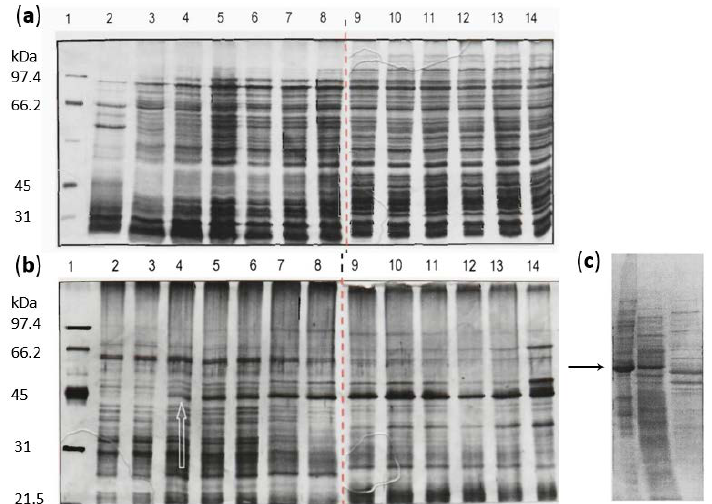
Figure 2. SDS-PAGE gel images for GCRL 46 cells cultured at pH 6.3 or 4.0. Cells were cultured anaerobically in fermenters at set pH of pH 6.3 (panel a ) and 4.0 (panel b ), sampling hourly from inoculation (lanes 2–13) and at 24 h (lanes 14) for analysis of whole cell preparations. Size markers are shown in lane 1. The red line shows where parallel gels have been joined to visualize these data; the white arrow indicates initial up-regulation of a protein band of approximately 42 kDa. Panel ( c ) shows (left to right) whole cells, cell debris after centrifugation and the cytosolic fractions for cells culture at pH 4.0 for 24 h. The black arrow points to the ca. 42 kDa protein band.